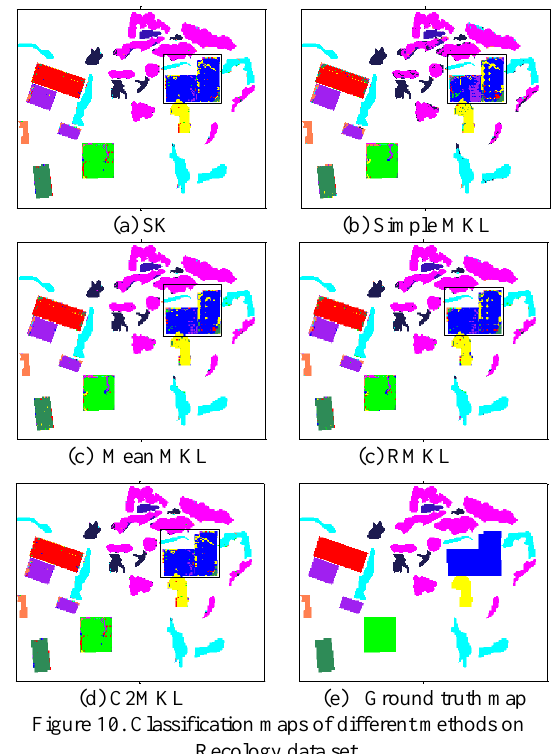
Figure 10. Classification maps of different methods on Recology data